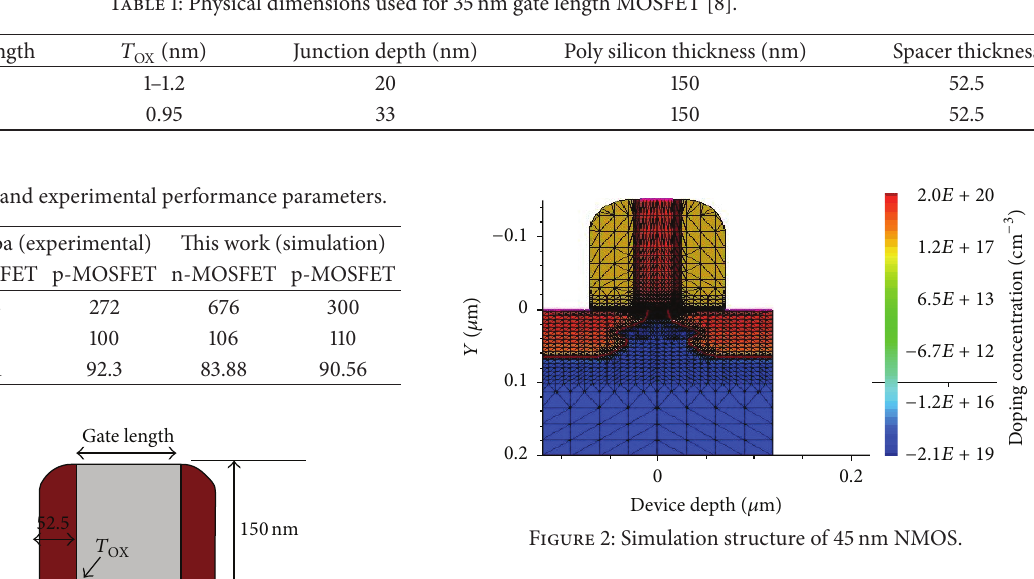
Table 1: Physical dimensions used for 35 nm gate length MOSFET [8].